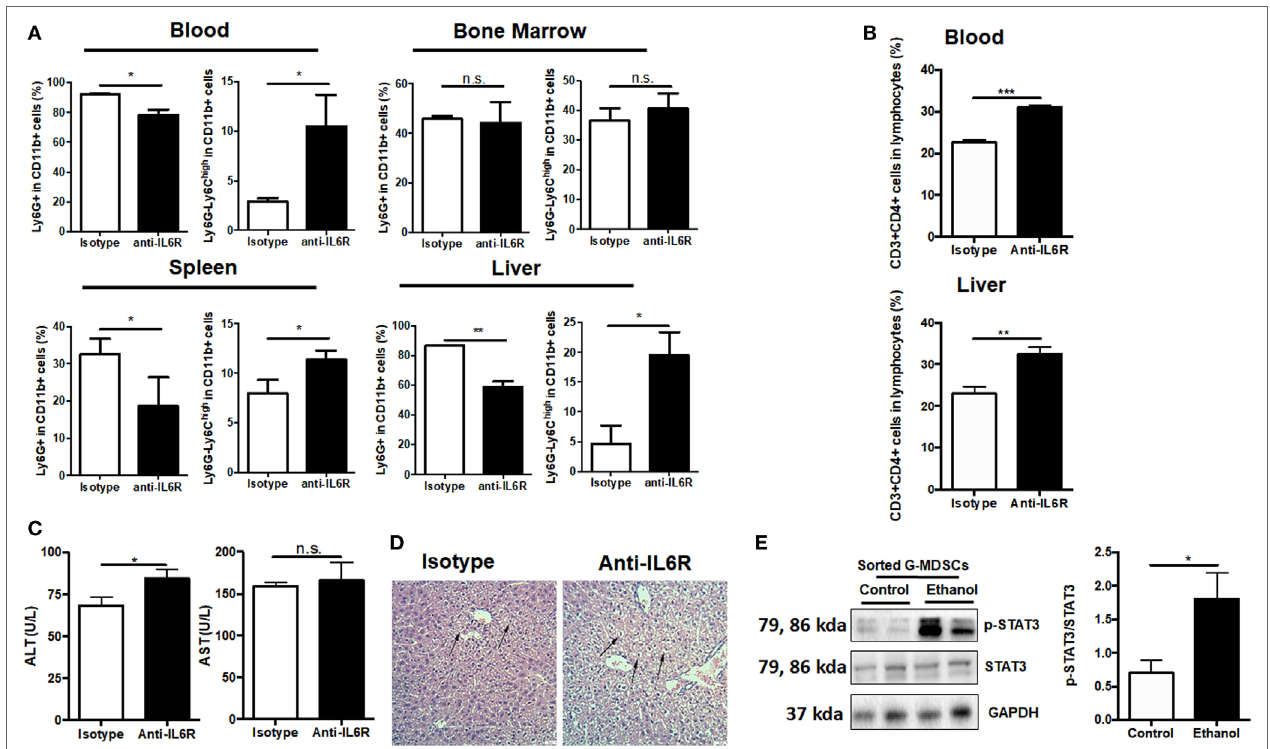
FigUre 6 | Role of IL-6 in mediating the expansion of granulocytic-MDSCs (G-MDSCs) populations. Anti-IL6R antibody (Bio X cell) or isotype antibody was injected i.p. into mice at a dose of 150 mg/kg per mouse ( n = 6 for each group). The populations of myeloid-derived suppressor cells (MDSCs) and T cells in blood and liver were determined by flow cytometer and then liver function was evaluated via serological and histological examination. (a) Population of MDSCs from the blood, spleen, liver, and bone marrow of mice treated with anti-IL6R or isotype antibody. (B) Population of cytotoxic T cells and T helper cells in blood and liver of mice treated with anti-IL6R or isotype antibody. (c) Alanine aminotransferase (ALT) and aspartate aminotransferase (AST) level in serum of mice treated with anti-IL6R or isotype antibody. (D) H&E staining images of liver tissues from mice treated with anti-IL6R or isotype antibody. The hepatocellular apoptosis and single cell necrosis were indicated by arrows. (e) Expression of p-signal transducer and activator of transcription-3 (STAT3), and STAT3 in G-MDSCs sorted from mice treated with ethanol or vehicle detected by western blotting. Data were analyzed as mean value ± SD and Student’s T -test was used to assess the result significance. * p < 0.05, ** p < 0.01, *** p < 0.001, compared with the control group; n.s., not